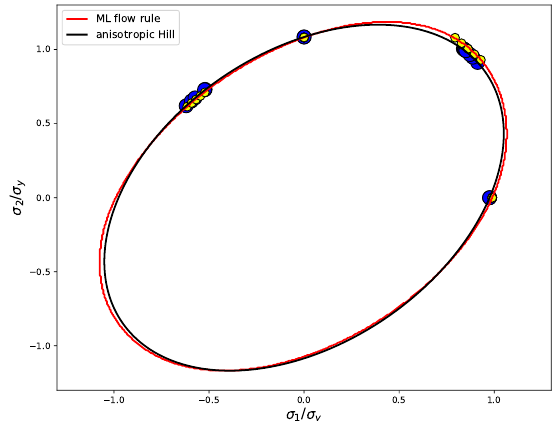
Figure 7. Stress states obtained for the four different plane-stress load cases are plotted in the σ 1 - σ 2 plane together with the yield loci of the trained ML flow rule and the Hill-like reference material. The flow stresses resulting from the ML yield function are plotted as small yellow circles and those from anisotropic Hill plasticity as large blue